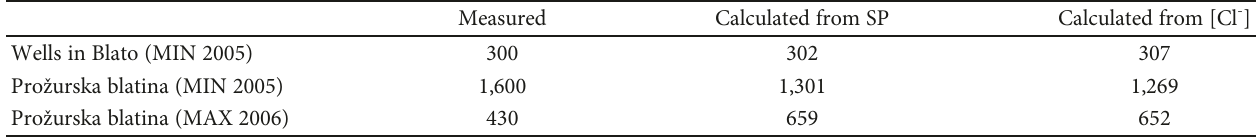
Table 4: Measured and theoretical sulphate anion concentrations in mg/l.